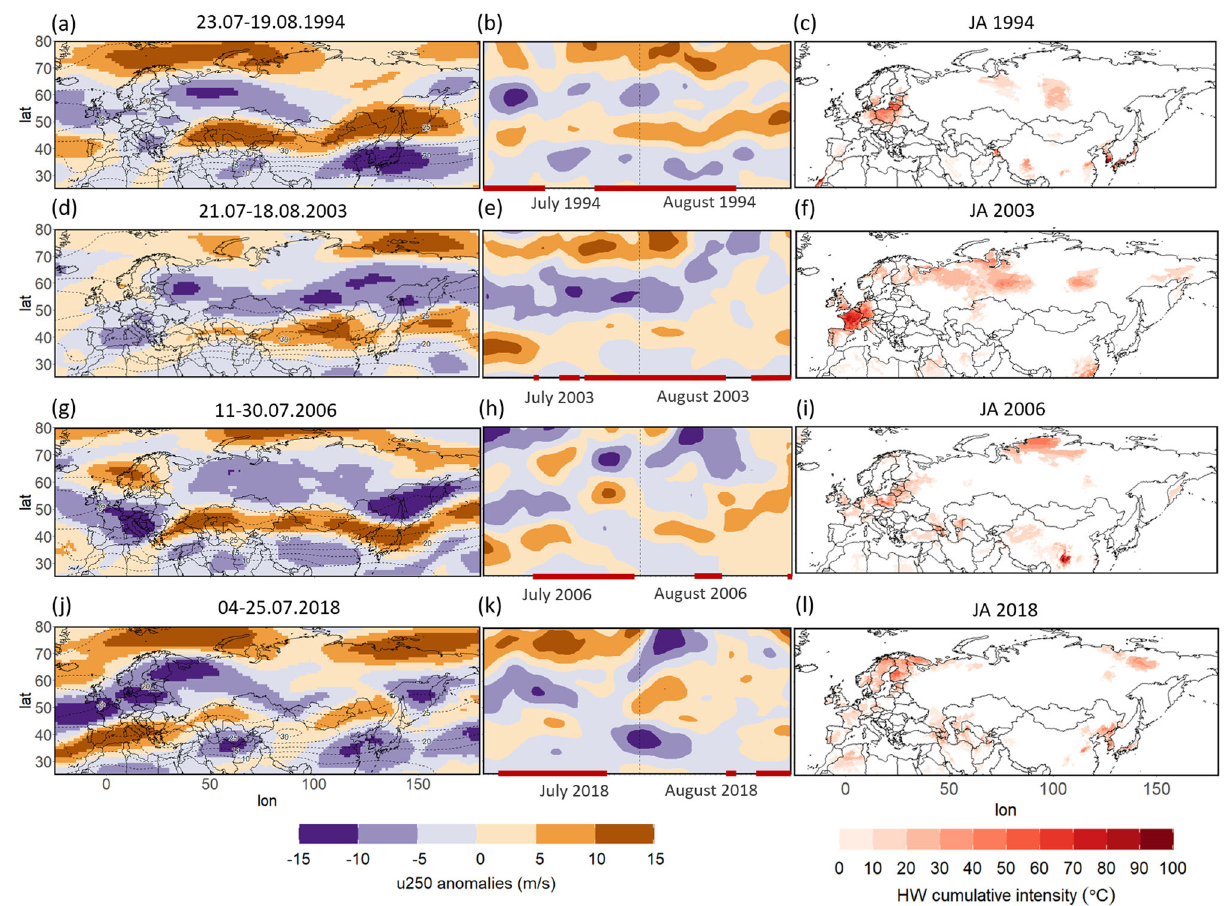
Fig. 4 Summers 1994, 2003, 2006, 2018: double jets and heatwave intensity. a Anomalies of the 250hPa zonal wind (u250; shading, anomalies from climatology; dashed contour lines show the total wind speed climatology plotted every 5 m/s) for the longest double jet event in 1994: 23.07-19.08.1994. b Hovmöller diagram of the Eurasian (region seen in panel a) zonal mean zonal wind anomalies for July-August 1994 (shading; 5day running means centered on each day from 01.07-31.08.1994). The vertical dashed line refers to the fi rst day of August and the red horizontal lines on the time axis show the days identi fi ed by the SOMs as double jets (dates for 1994: 1-12.07, 23.07-19.08). c Spatial distribution of heatwave cumulative intensity for July- August 1994. d As in a but for 21.07-18.08.2003. e As in b but for July-August 2003 (dates of all double jets for 2003: 11.07, 16-19.07, 21.07-18.08,